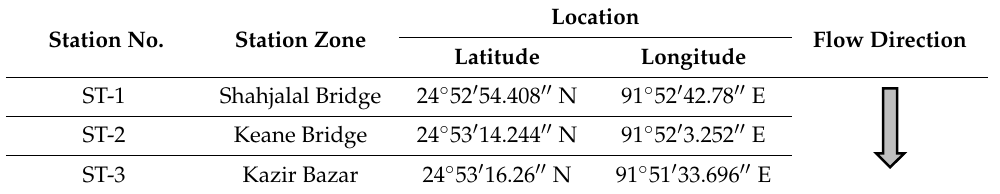
Table 1. Sampling stations with location.